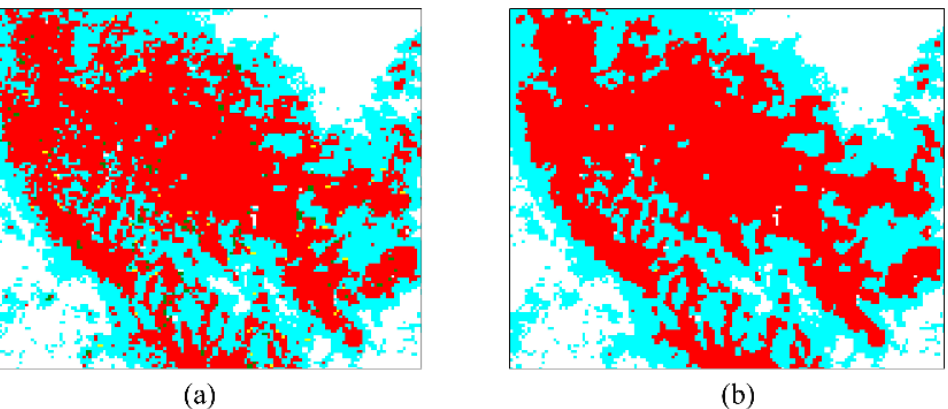
Figure 8. Diagram of the processing result of the Clump method (Red for clouds, green for green tide, blue for clean water): ( a ) pre-method results and ( b ) post-method results.